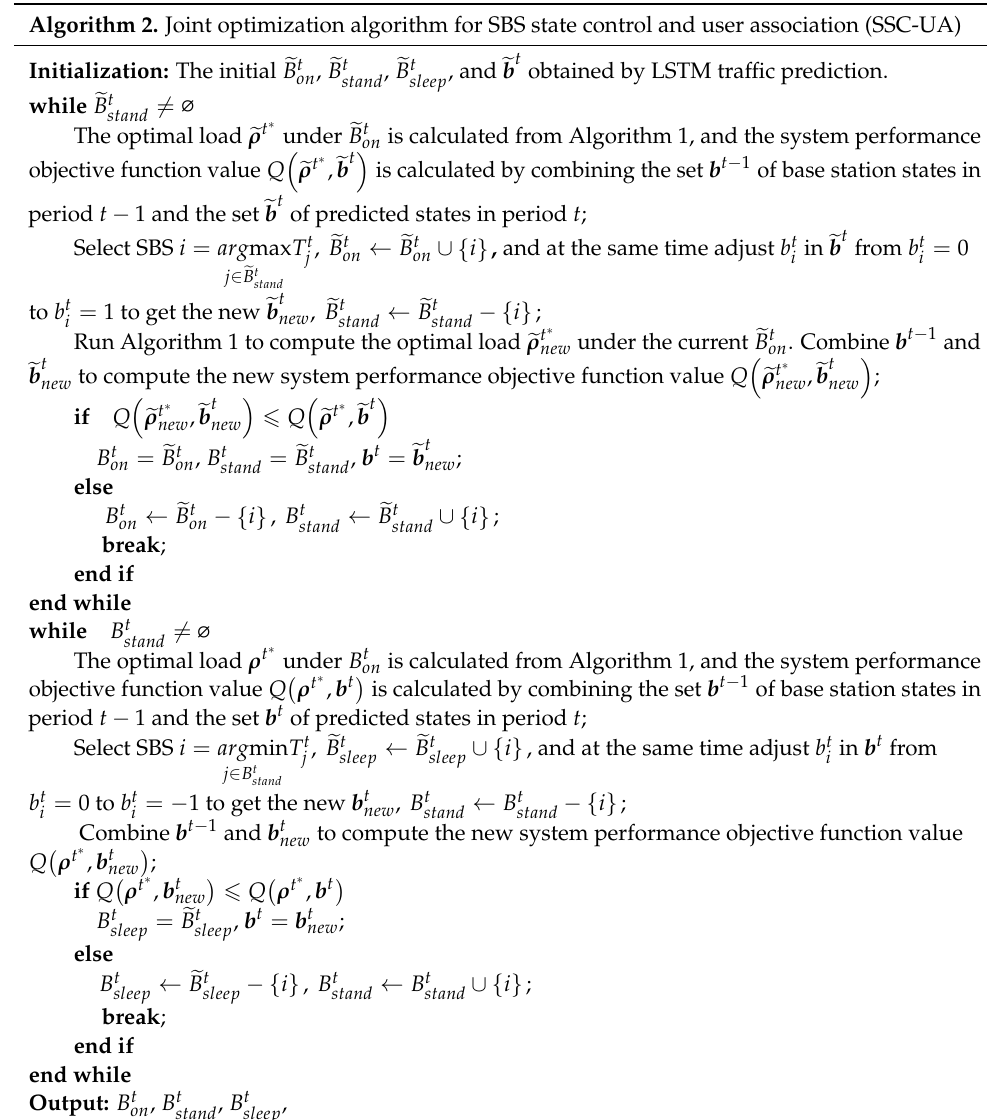
Algorithm 2. Joint optimization algorithm for SBS state control and user association (SSC-UA)